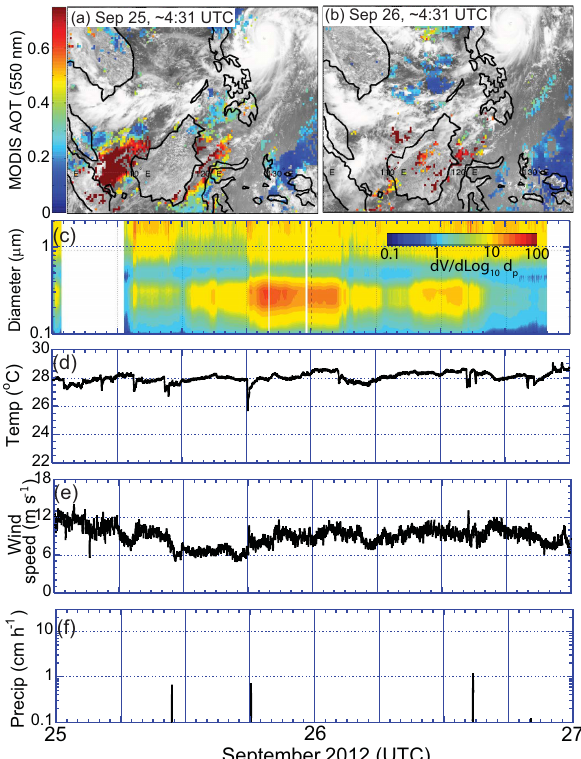
Figure 8. Same as Fig. 7 but for the 25–26 September 2012 smoke event.